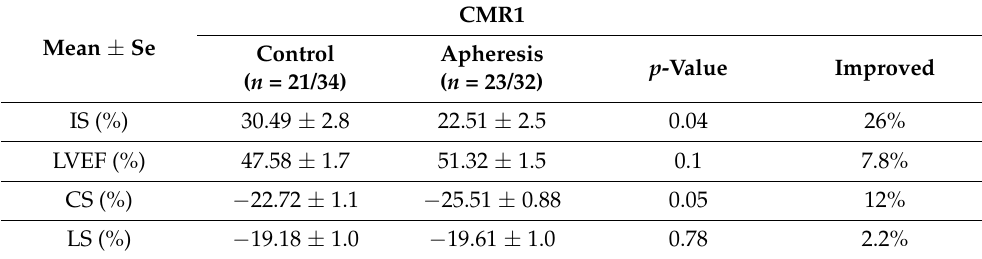
CMR2 = second Cardio Magnetic Resonance, CS = Circumferential Strain, IS = Infarc Size, LS = Lon- gitudinal Strain, LVEF = Left Ventricular Ejection Fraction.